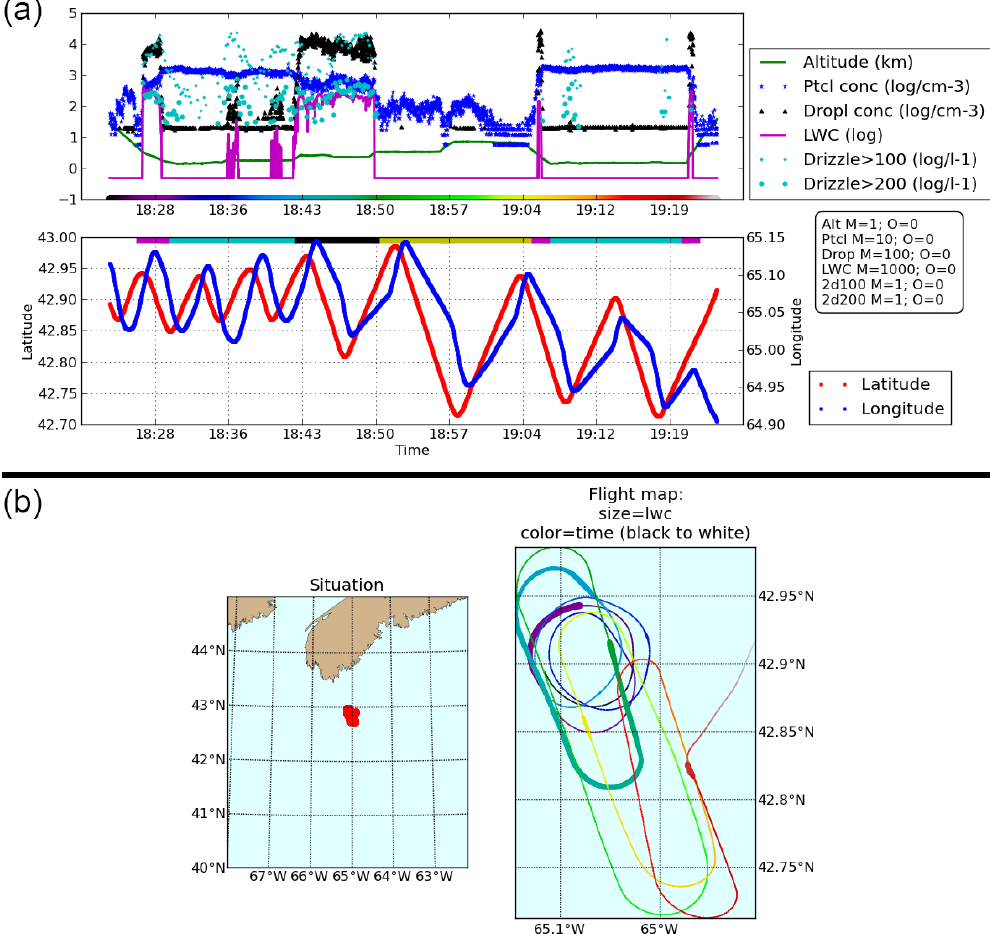
Figure 4. Panel (a) shows a qualitative view of the aircraft’s altitude, the measured particle and cloud droplet total concentrations, the liquid water content and drizzle drop concentration in its upper subplot, and the aircraft’s latitude and longitude on the lower subplot. All the data in the upper subplot can be magnified and/or offset (values of which are indicated in the rounded box on the right-hand side of the plot). At its bottom, a colour-coded time tracker is inserted. The lower subplot shows the latitude (left axis) and longitude (right axis) of the aircraft or probe. At its top, the colours indicate which manoeuvre the aircraft is making (magenta = vertical, cyan = below cloud, black = horizontal in cloud and yellow = above cloud). Panel (b) shows the path of the aircraft or probe while the cloud instance was being measured. The subplot on the left shows a zoomed-out map and the subplot on the right shows a zoomed-in situation, with the size of the points corresponding to the liquid water content and the colour corresponding to the time tracker in the time series (Panel (a)